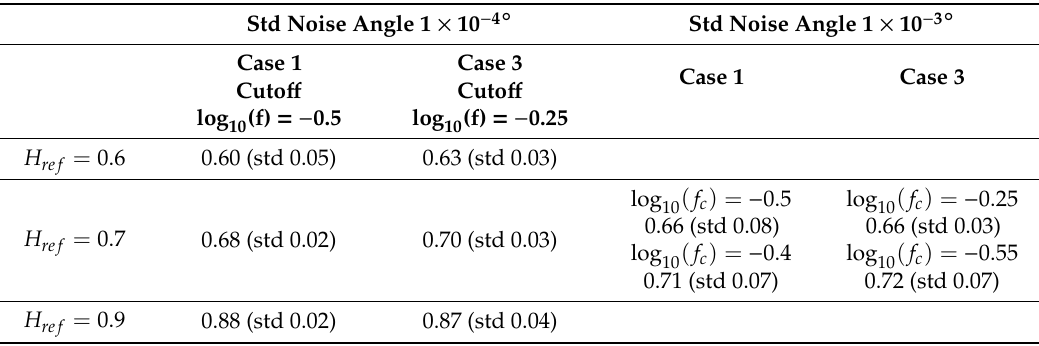
Table 3. Estimation of the Hurst parameters from the residuals for case 1 and case 3, with the GHE and with additional angle noise for two standard deviations (1 × 10 − 4 ◦ and 1 × 10 − 3 ◦ ). H ref = 0.6, 0.7, and 0.9. The cuto ff frequencies ( f c ) are visually